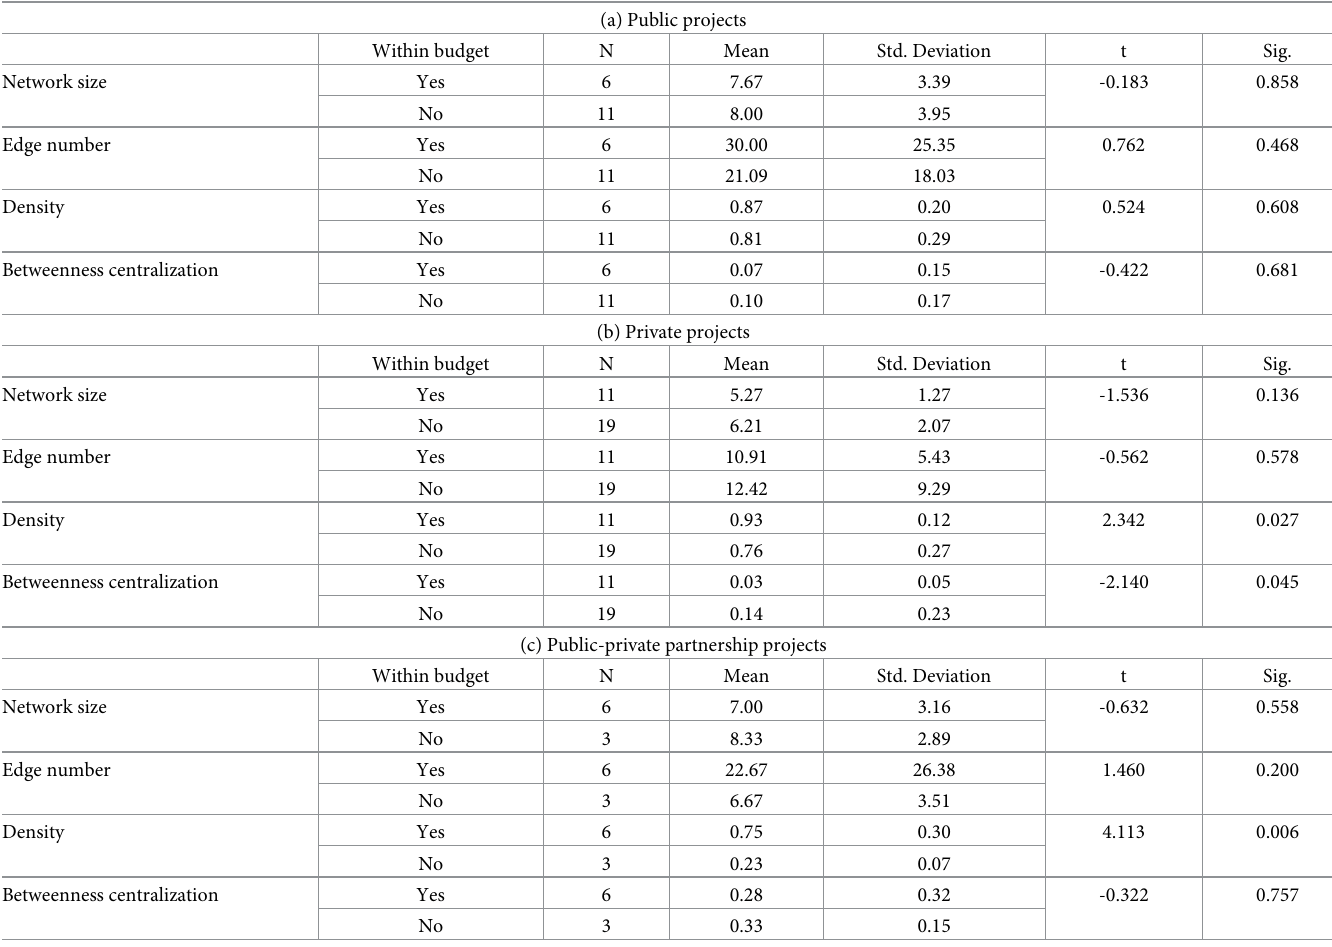
Table 4. Results from the independent sample t-test for four network measures. Each project is grouped based on its cost performance (within budget or